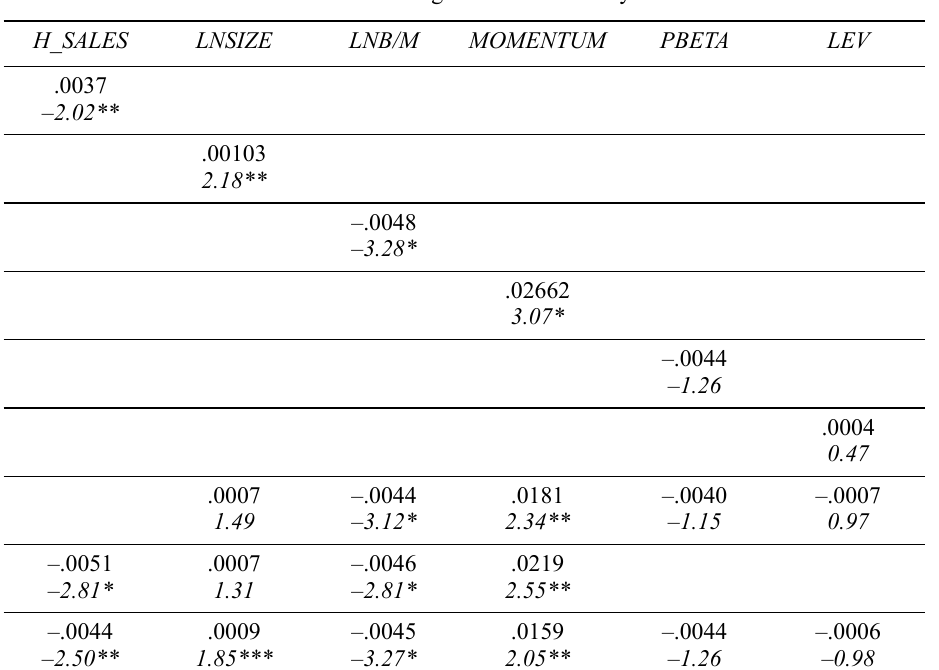
Table 5. Fama-MacBeth regressions of industry-level